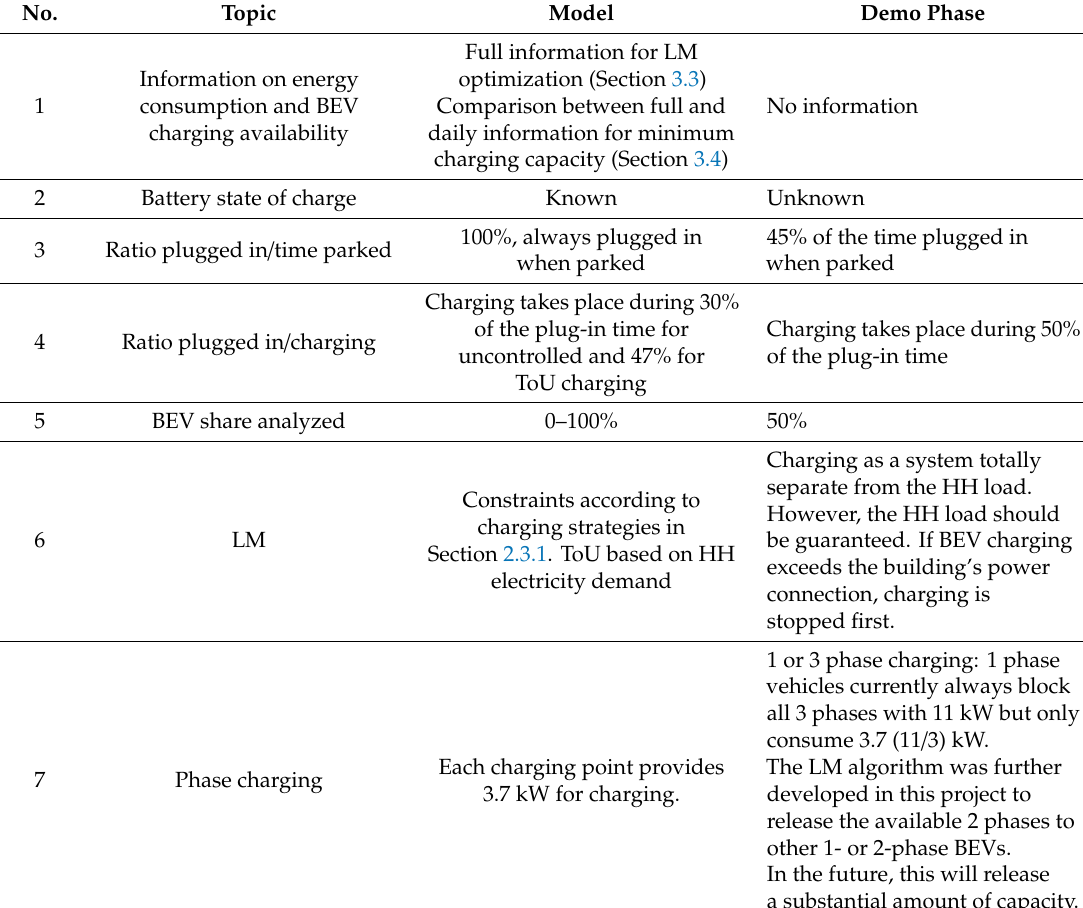
Table 4. Di ff erences between the modeled and the real